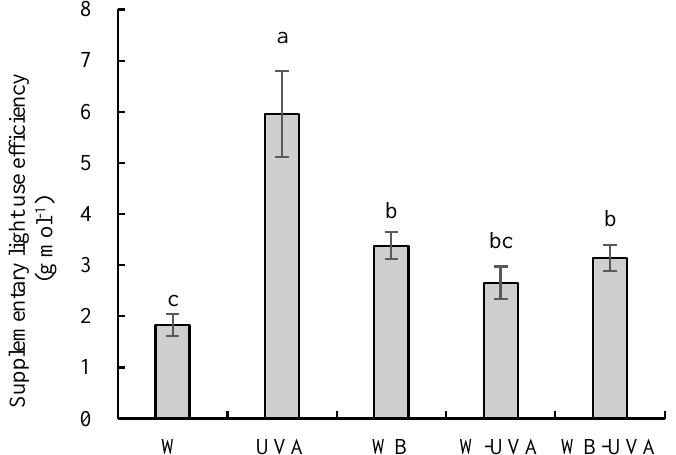
Figure 4. Supplementary light use efficiency of greenhouse-grown cucumber seedlings cultivated under supplementary white (W), UV-A light-emitting diodes (LEDs), and various combinations of W, blue (B), and UV-A LEDs at 22 days after sowing; cucumber seedlings grown without supplementary light were used as control. Different letters within each parameter were significantly different tested by the least significant difference (LSD) test at p < 0.05.